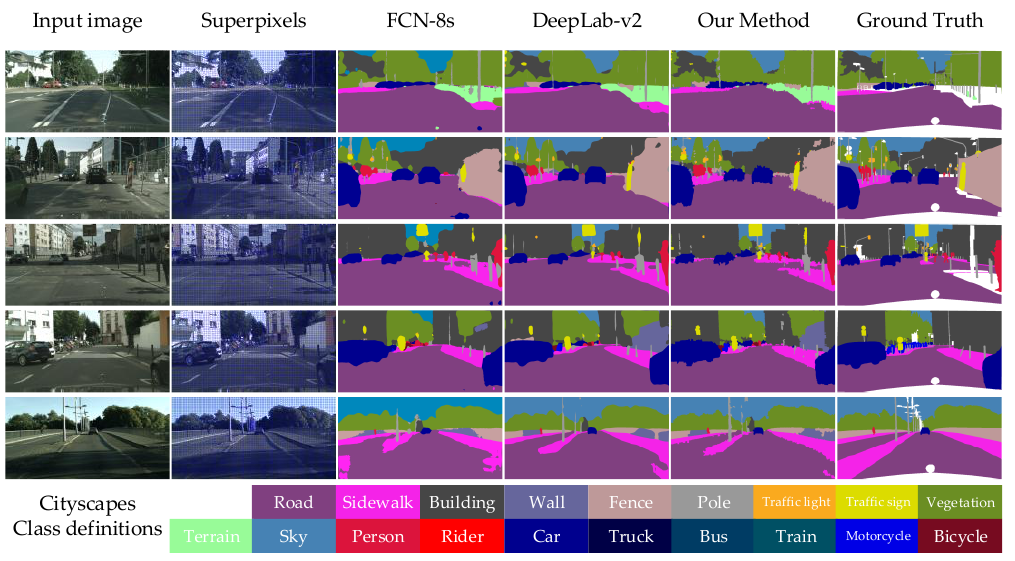
Figure 11. Visual results on the validation set of Cityscapes. From left to right: the original image, SLIC segmentation, FCN-8s results, DeepLab-v2 results, our results, and the ground truth.